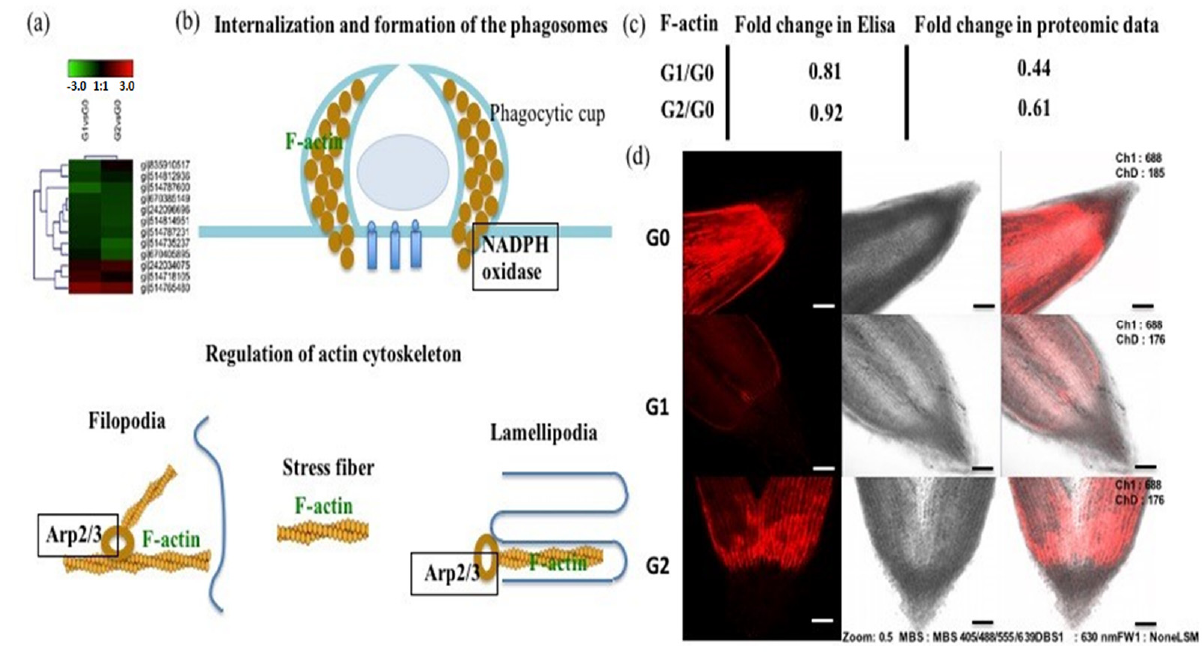
Figure 8. Distribution of F ‐ actin in C. spinifex root tip cells under drought stress conditions compared to unstressed controls. ( a ) Heat map visualization of DAPs involved in the cytoskeleton. ( b ) F ‐ actin regulates the internalization and formation of phagosomes and the actin cytoskeleton. ( c ) Abundance of F ‐ actin based on ELISA results and proteomic data. ( d ) Root tip cells stained with phalloidin, showing the distribution of F ‐ actin (scale bar = 10 μ m).